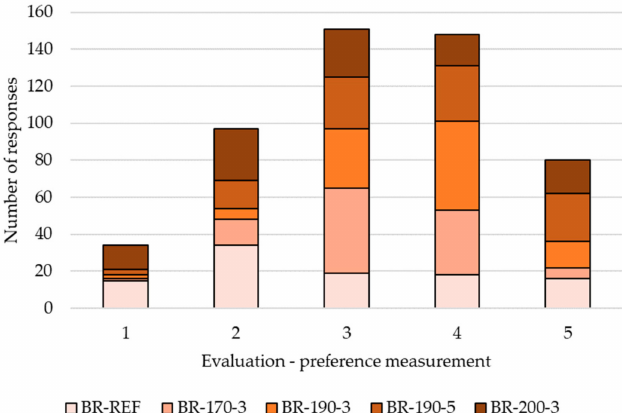
Figure 17. The distribution of the sample colors depending on the preference level—birch veneer. BR-REF = untreated birch veneer; BR-170-3 = birch veneer treated at 170 ◦ C / 3 h; BR-190-3 = birch veneer treated at 190 ◦ C / 3 h; BR-190-5 = birch veneer treated at 190 ◦ C / 5 h; BR-200-3 = birch veneer treated at 200 ◦ C / 3 h.